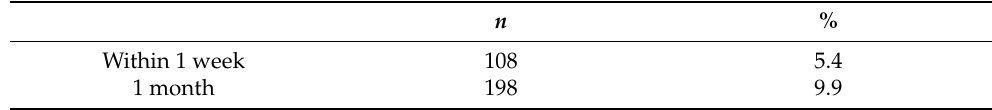
Table 8. Duration of dietary supplement